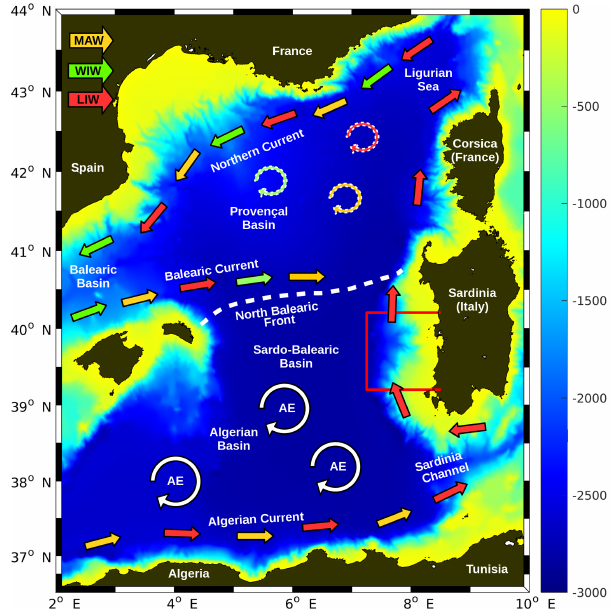
Figure 2. The large-scale circulation of the western Mediterranean as it was known before the REP14-MED experiment. White-dashed circles indicate notional mesoscale eddies. The red box is the obser- vational domain. Algerian eddies are marked by AE. For the other acronyms, see the